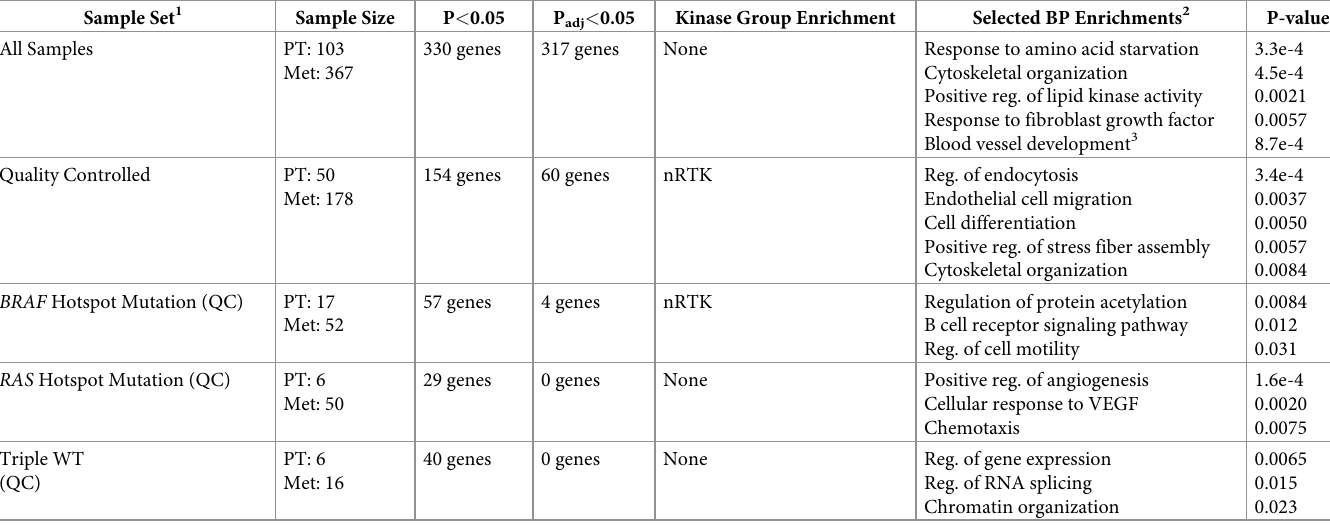
Table 5. Summary of kinase differential isoform ratio